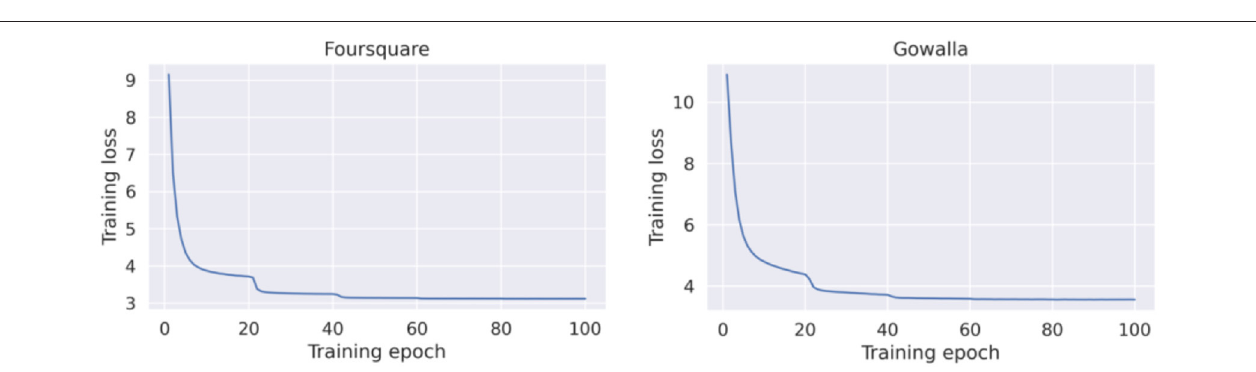
the smallest. This is reflected by the number of